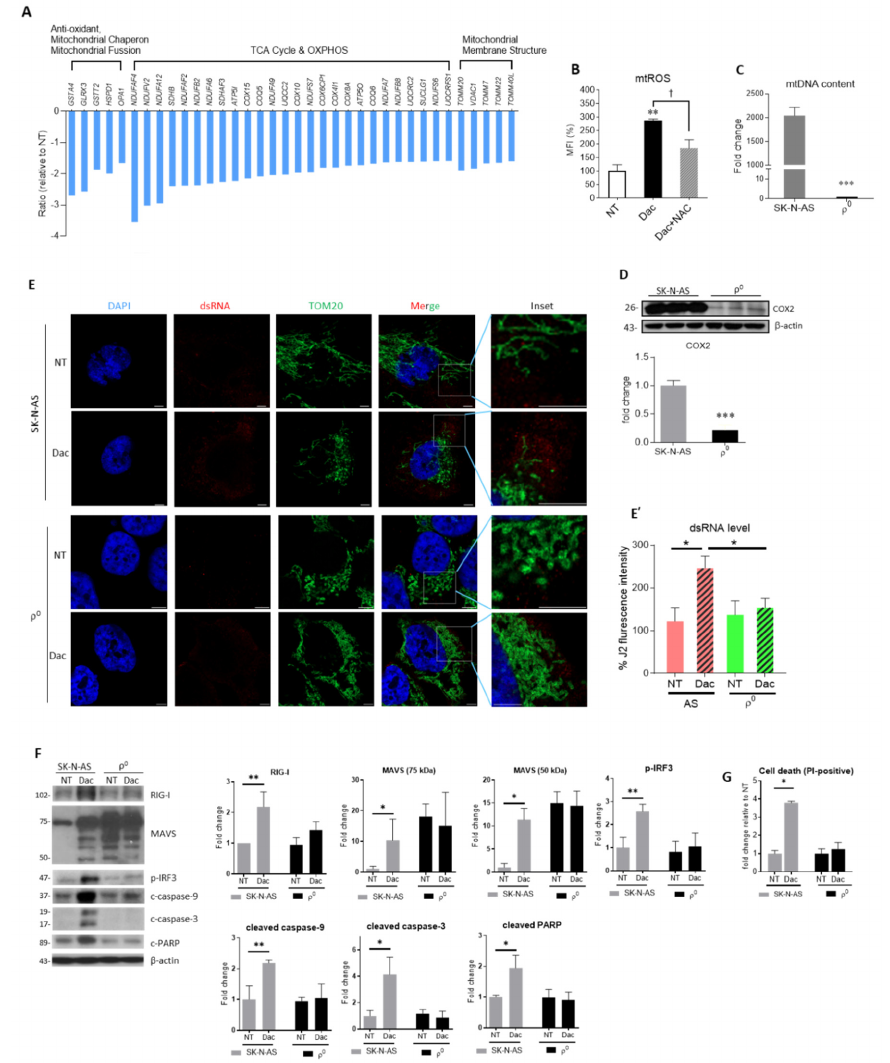
Figure 3. mtDNA is required for Dac-activated dsRNA abundance and innate immune response and apoptosis. ( A ) SK-N-AS cells treated with 2.5 μ M Dac or NT for 5 days were harvested and subjected to microarray analysis. Histogram showing down-regulated mitochondrial genes regarding anti-oxidant, chaperon, fusion, tricarboxylic acid cycle (TCA) cycle, oxidative phosphorylation (OXPHOS) and mitochondrial membrane structure; ( B ) mitochondrial ROS (mtROS) probed by MitoSox TM red staining and detected by a flow cytometry was expressed as percentage of mean fluorescence intensity (MFI). Co-treatment of 10-mM N-acetylcysteine (NAC) for 5 days serves as a ROS scavenger control; ( C ) mtDNA content of SK-N-AS and ρ 0 cells was measured using qRT-PCR; ( D ) representative western blot results and densitometric quantification data of mtDNA-encoded COX2. β -actin serves as the loading control for normalization. *** p < 0.001 compared to SK-N-AS cells. ( E ) representative immunofluorescent image of dsRNA (red), mitochondrial outer membrane marker TOM20 (green) and DAPI-stained nuclei (blue) in ρ 0 cells. Scale bar, 5 μ m. Insets contain magnified images highlighting mitochondria and dsRNA. ( E’ ) percentage of J2 fluorescence intensity (a.u., arbitrary unit) was quantified (representative images shown in Supplementary Figure S6B) under lower magnification (100X) of an Olympus FV10i confocal microscope. * p < 0.05 between indicated groups; ( F ) representative western blot of RIG-I, MAVS, p-IRF3, cleaved caspase-9, -3 and PARP are shown. β -actin serves as the loading control; ( G ) cell death rate was detected using PI or TB staining with flow cytometry. * p < 0.05, ** p < 0.01 when compared to NT or parental cell group. † p < 0.05 between indicated groups. NT—untreated; MFI—mean fluorescence